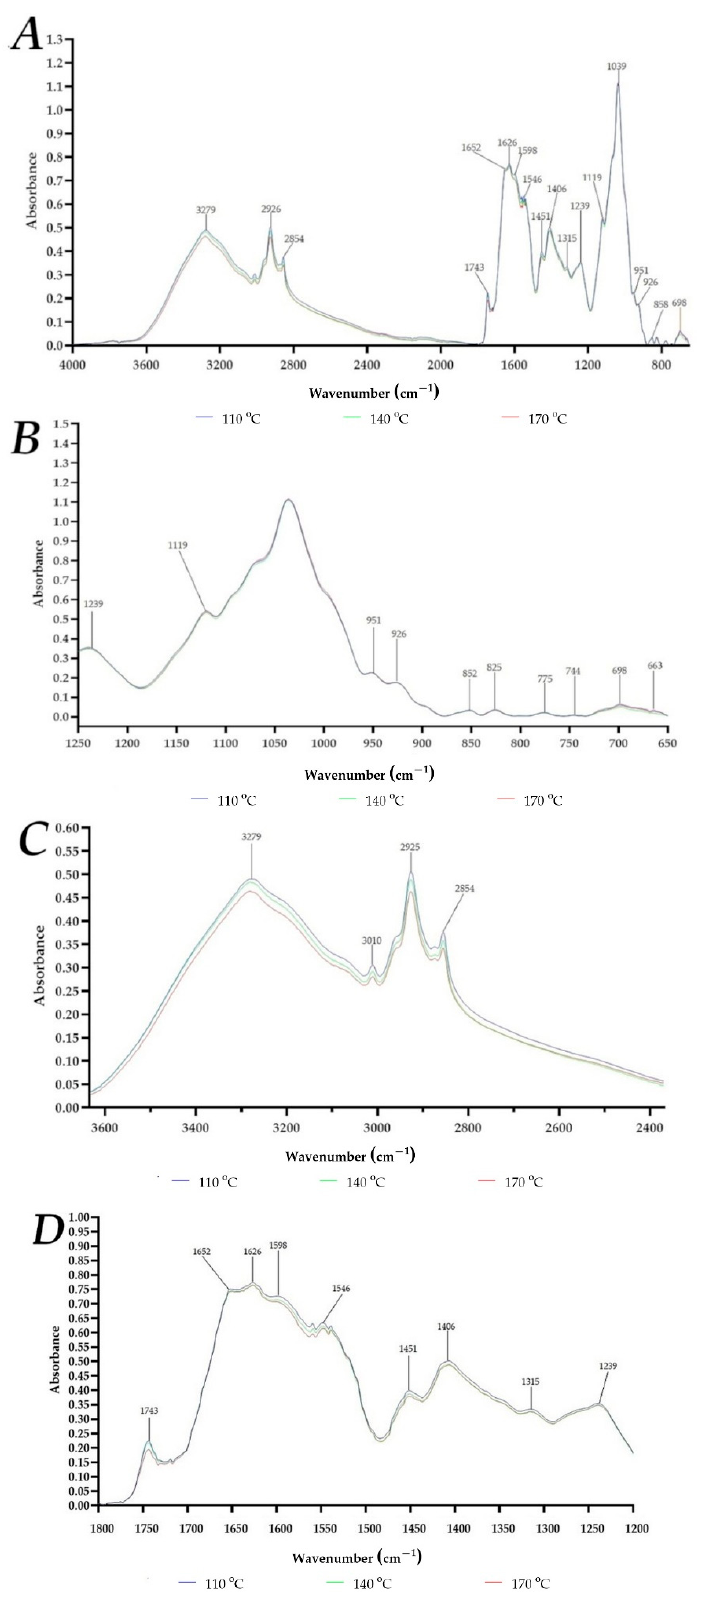
Figure 2. FTIR spectra of FOCE-LGG powders. ( A ) whole FTIR spectrum (4000–650 cm − 1 ); ( B ) in the range of 1250–650 cm − 1 (polysaccharides); ( C ) in the range of 3600–2400 cm − 1 ( − OH, − NH, − CH2 and − CH3 groups); ( D ) in the range of 1800–1200 cm − 1